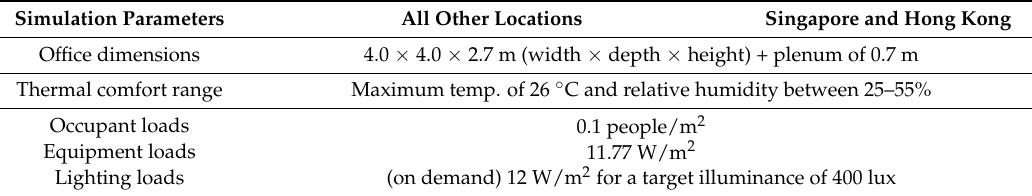
Table 2. Design and operational parameters for the dynamic energy simulation of the base case defined for the